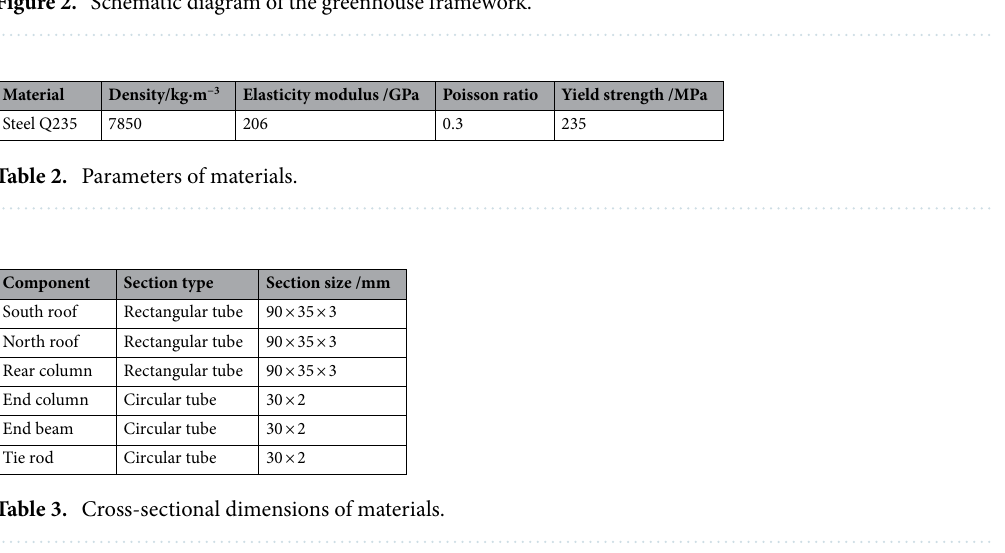
Figure 2. Schematic diagram of the greenhouse framework.